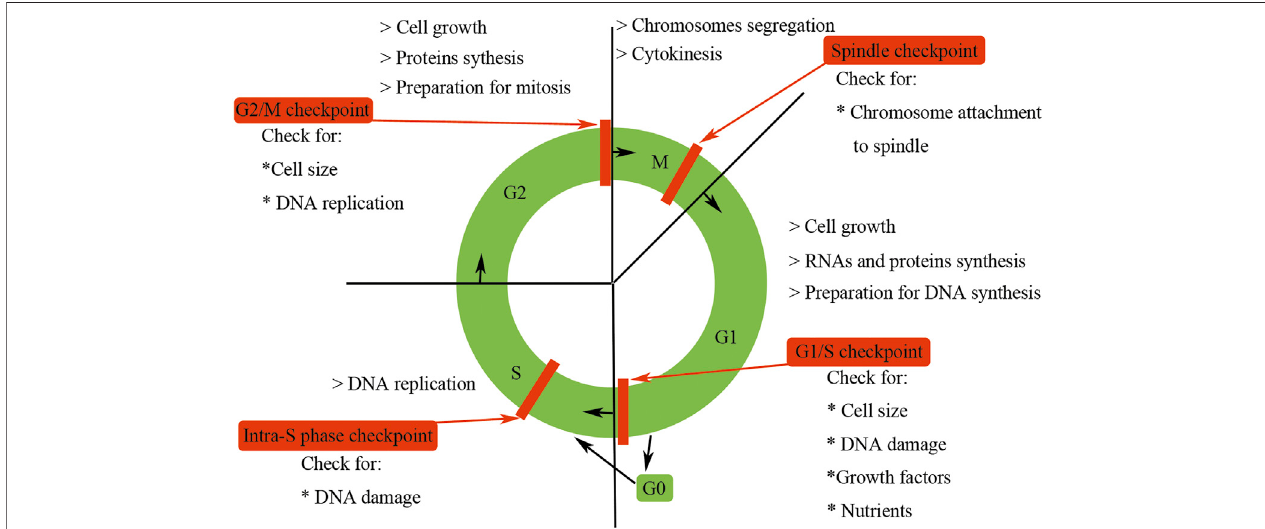
FIGURE1| Featuresofthemammaliancellcycle.Mammaliancellcycleistightlyregulatedandcanbearti fi ciallydividedintofourdistinctphases(G1,S,G2,andM) according to their speci fi c characteristics. G0 phase is usually used to describe cells that have exited the cell cycle and become quiescent. The progression of the mammalian cell cycle is precisely controlled by CDKs, cyclins, and CKIs. Checkpoints could ensure the processes at each phase of the cell cycle have been accurately completed before entering into the next phase.